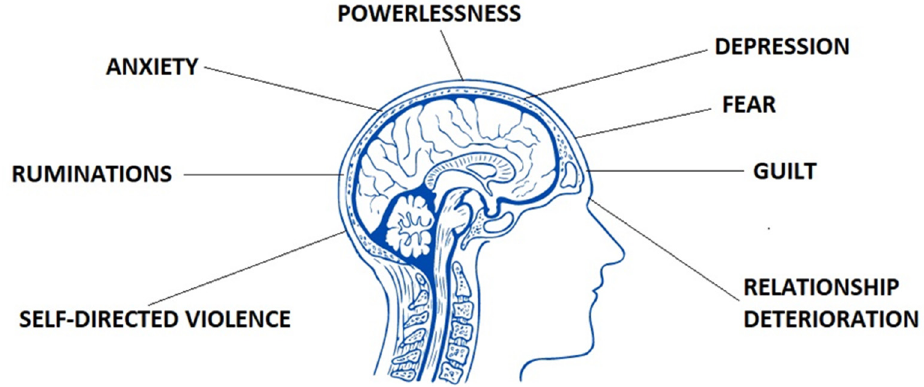
Figure 2. Mental states which may occur in women who suffer from endometriosis.